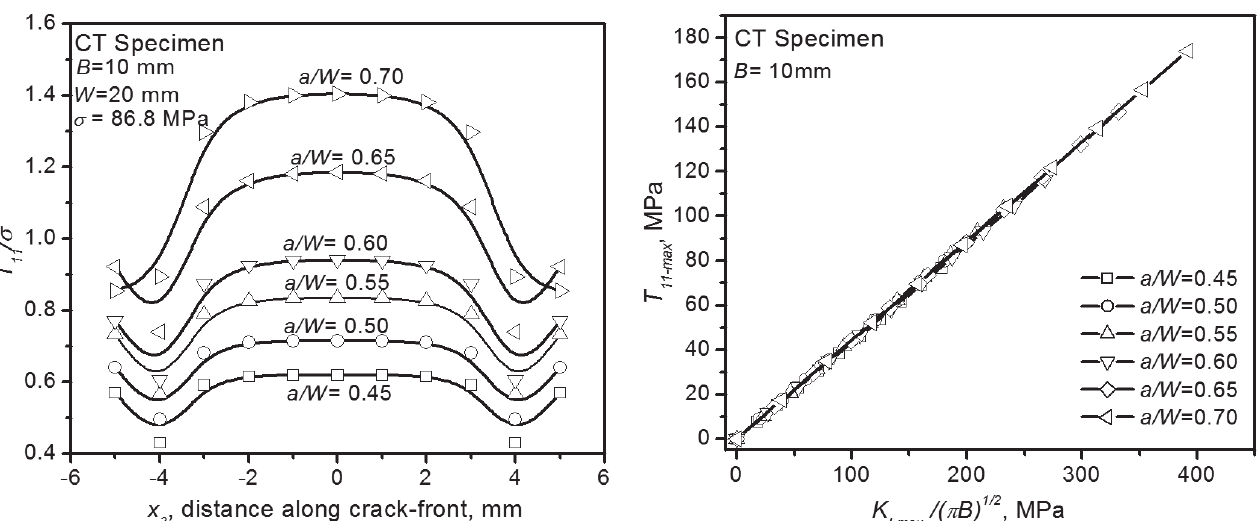
Figure 7: Variation of T 11-max against K I-max / π B 1/2 for various a/W and B =10 mm.